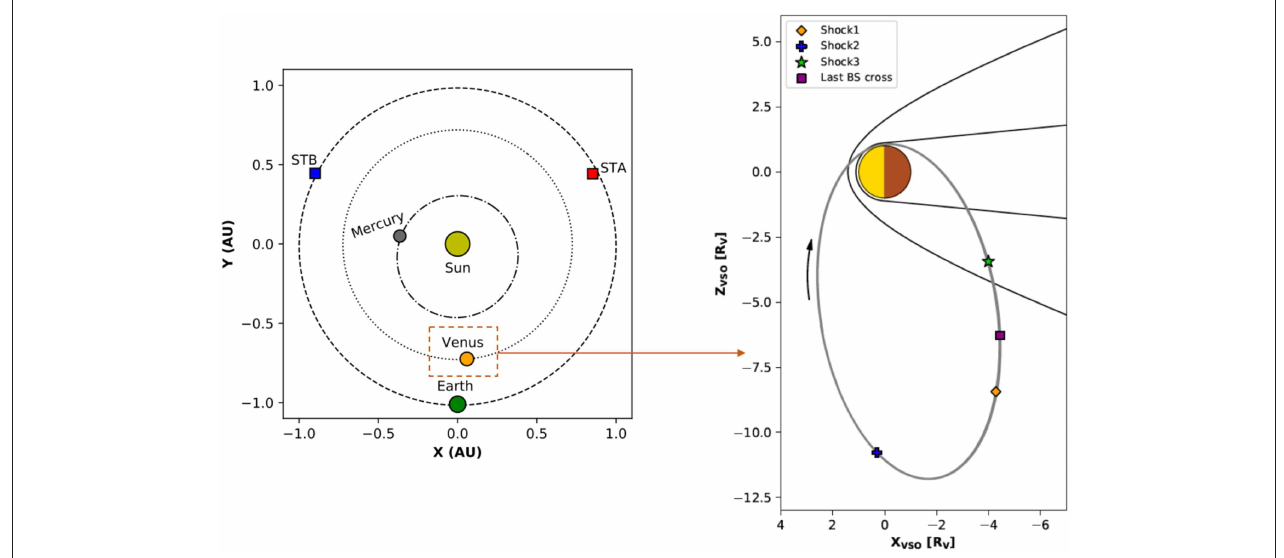
FIGURE 1 | Left : Position of the planets in the inner heliosphere in the ecliptic plane on June 14, 2012. The CME launched on June 14 subsequently arrived at Venus and Earth, which were almost radially aligned at this time. Venus Express (VEX) was orbiting Venus and the Wind and ACE spacecraft were located at the L1 point close to Earth. Right : The orbit of VEX (solid gray line, the orbital direction is indicated by the arrow) around Venus during the time when the June 14 CME reached Venus. The locations of the nominal bow shock (BS) and ion composition boundary (Martinecz et al., 2008) are indicated with black solid lines. Symbols along the orbit indicate the position of VEX during the passage of the interplanetary shocks and the last outbound BS crossing, when VEX entered from the magnetosheath into the solar